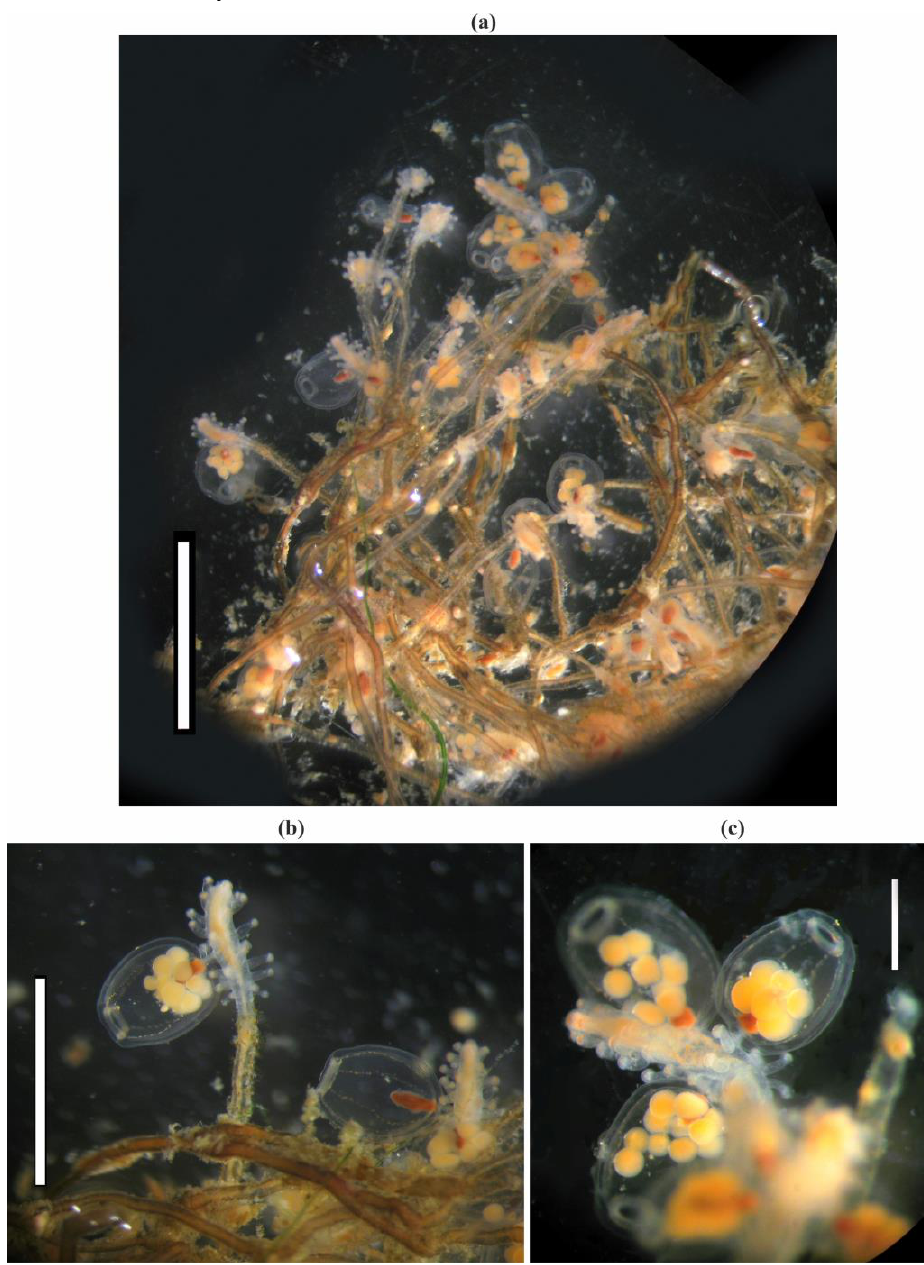
Figure 3. Coryne hincksi from the Barents Sea. ( a ) — overall view of a colony, scale bar 5 mm, ( b ) — female sporosacs, scale bar 3 mm, ( c ) — female sporosacs, scale bars 1 mm. Photo by Panteleeva, N.N.